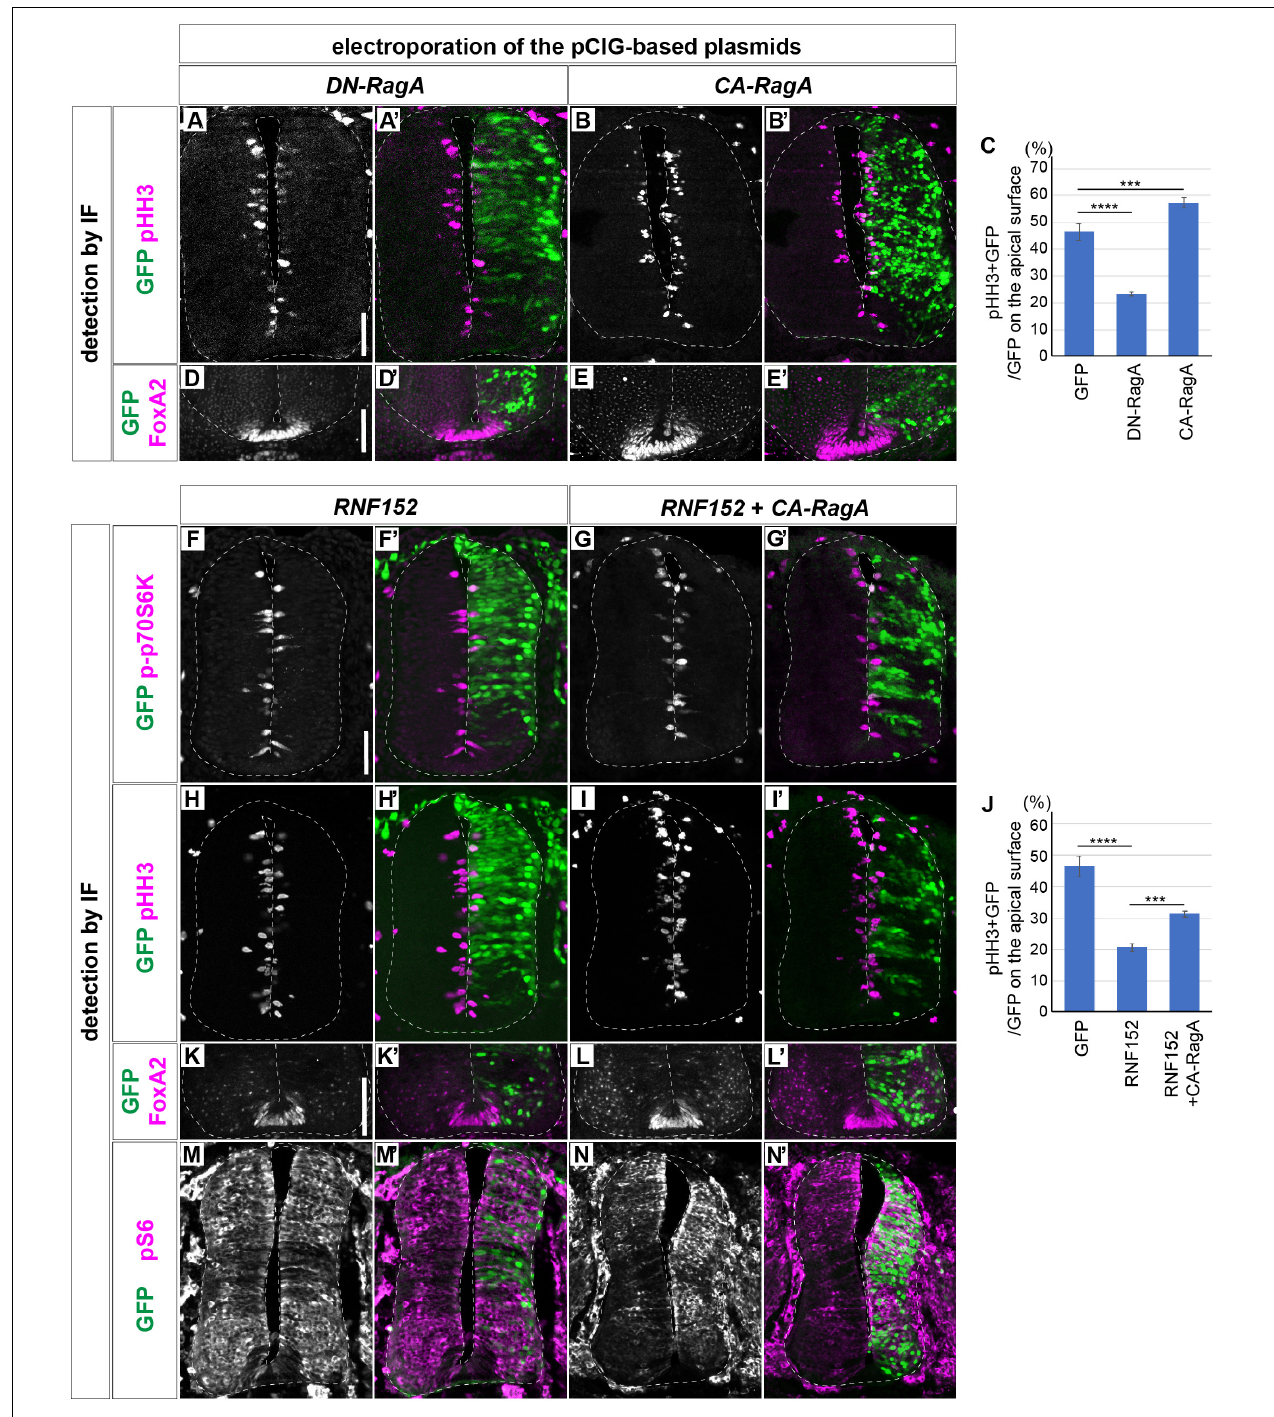
FIGURE 5 | RNF152 negatively regulates the cell proliferation through the mTOR signaling pathway. (A–E’) Cell proliferation is regulated by the RagA activity. pCIG-DN-RagA (A,A’,D,D’) or pCIG-CA-RagA (B,B’,E,E’) was electroporated at HH stage 12 and phenotypes were analyzed at 48 hpt with pHH3 (A–B’) , FoxA2 (D–E’) , and GFP (A’,B’,D’,E’) antibodies. (C) Quantitative data for (A–B’) . The rates of the pHH3/GFP-double positive cells over the GFP-positive cells on the apical surface are presented. Scale bars in (A) for (A–B’) and in (D) for (D–E’) = 50 µ m (F–J) RNF152 negatively regulates mTOR signaling and cell proliferation without altering the cell fate of the FP. pCIG-RNF152 (F,F’,H,H’,K,K’,M,M’) or RNF152 together with CA-RagA (G,G’,I,I’,L,L’,N,N’) were electroporated at HH stage 12 and the p-p70S6K (F–G’) , pHH3 (H–I’) , FoxA2 (K–L’) , pS6 (M–N’) , and GFP (F’,G’,H’,I’,K’,L’,M’,N’) expression was analyzed by immunofluorescence at 48 hpt. Quantitative data for (H–I’) in (J) . The counting was performed as in Figures 3M , 5C . In (C,J) , the data of the control GFP electroporation is identical to that in Figure 3M . Scale bars in (F) for (F–I’,M–N’) and in (K) for (K–L’) = 50 µ m. ∗∗∗ p < 0.001, ∗∗∗∗ p < 0.0001.